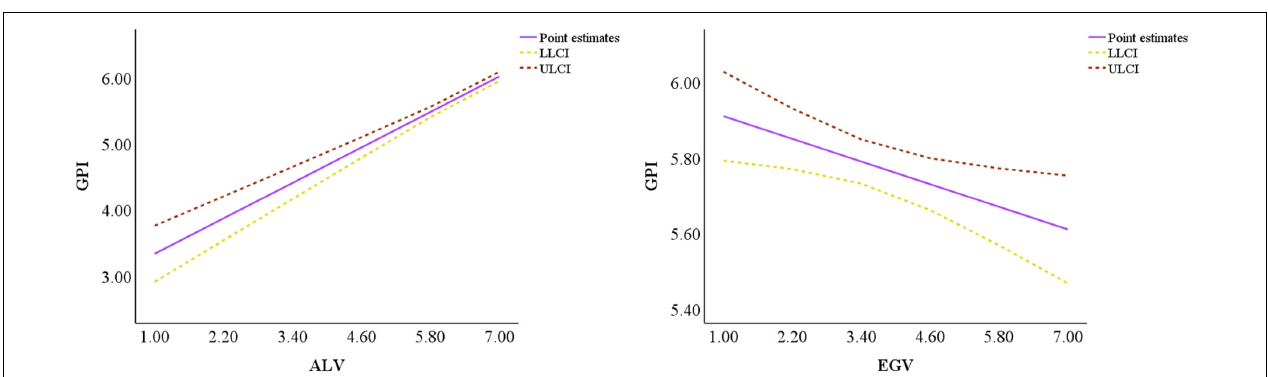
FIGURE 4 | Comparison of the effect of dual values on green purchasing